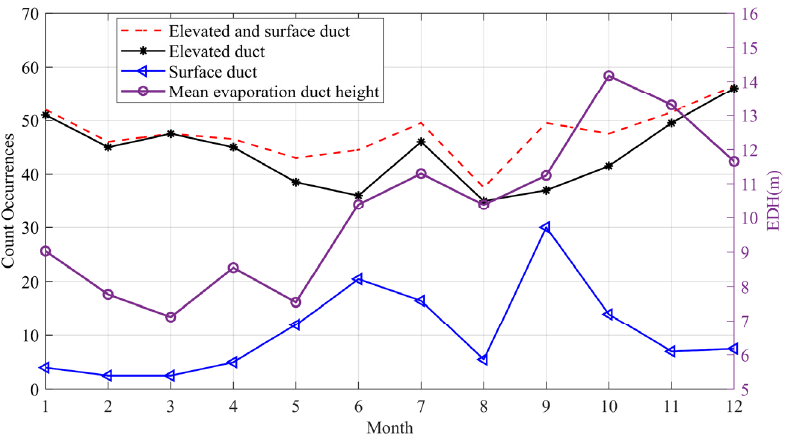
Figure 9. Statistical analysis of hybrid atmospheric ducts.